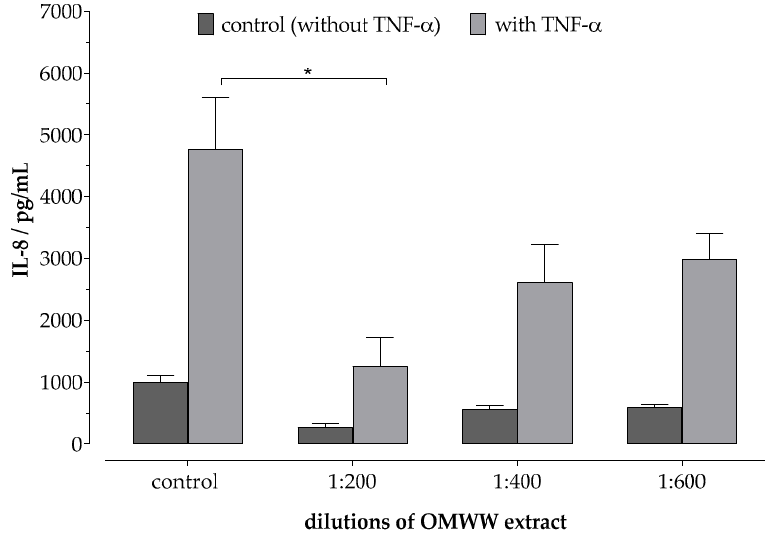
Figure 3. Determination of IL-8 release in HaCaT cells after treatment with 10 ng / mL TNF- α (controls without TNF- α ) and incubation with the OMWW extract dilutions for 72 h. MW ± SD, n = 3, *p ≤ 0.05 (each in triplicates).